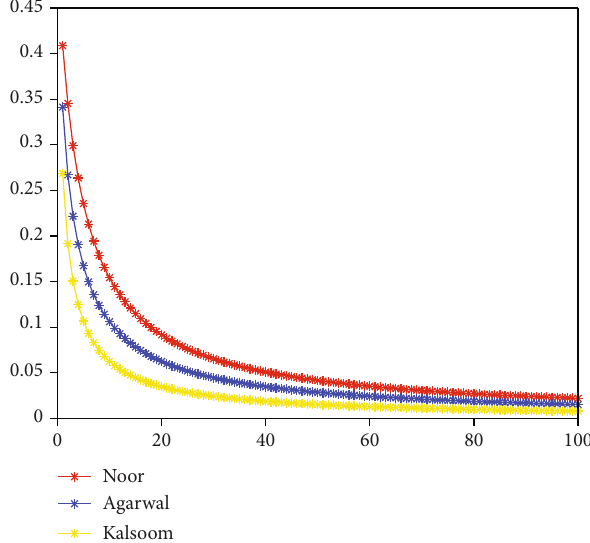
Figure 2: Convergence behavior of Noor, Agarwal, and Kalsoom et al. iterations towards fi xed point.